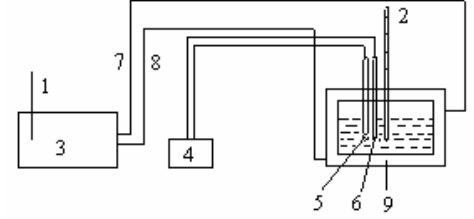
Figure 1. The design drawing of self-made jacketed crystallizer